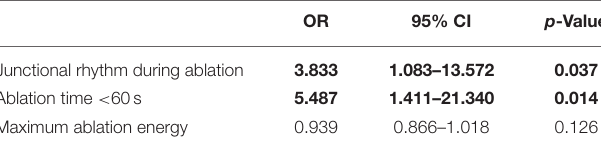
TABLE 3 | Multi-factor logistic regression analysis of factors predicting the